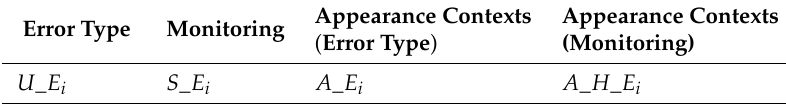
Figure 8. Failure mode and effects analysis (FMEA)_Health Management (HM) pattern for BN where the S _ U , S _ Ei nodes represent the sensor nodes of either a hardware or a software monitor, the nodes U , U _ Ei are the internal states possibly affected by an error Ei , the H _ U node represents the health of the system, H _ S and H _ Ei nodes represent the health of the sensor and the A _ H , A _ H _ Ei are the appearance contexts. Table 1. FMEA table for an error type Health Management ( FMEA _ HM